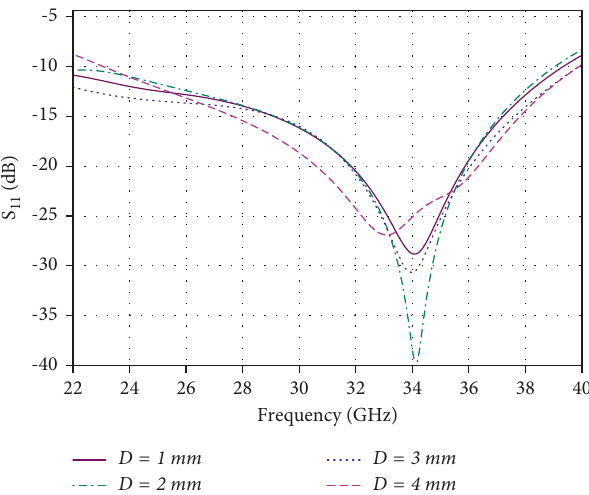
Figure 12: Simulated return loss characteristics of the proposed MIMO system for various values of ‘D’.